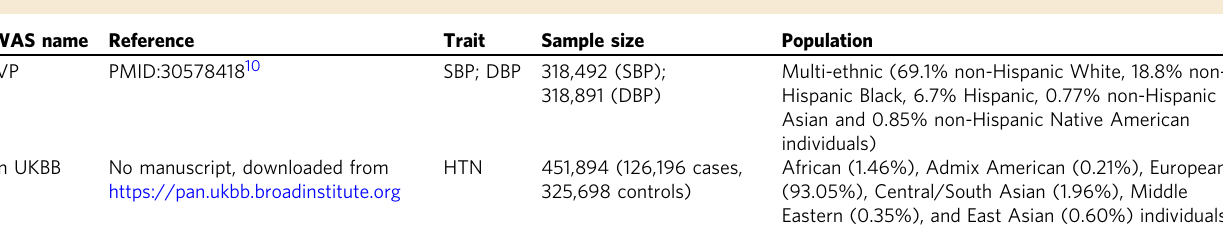
Table 1 External GWAS used for hypertension PRS